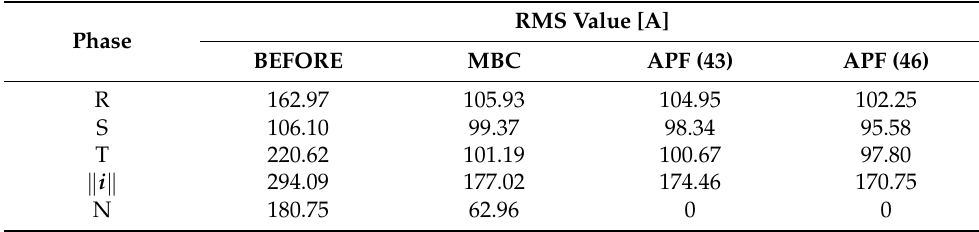
Table 7. List of the RMS value of the currents of the lines before compensation and after using the passive and active compensation.